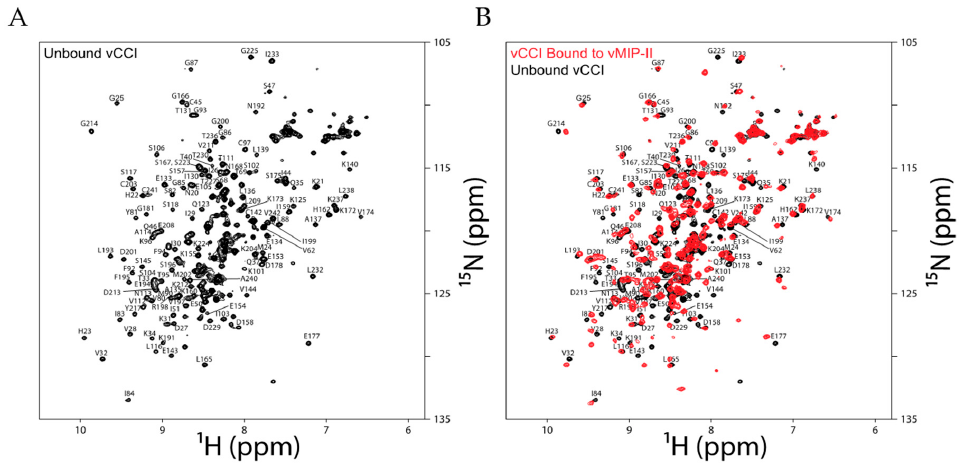
Figure 1. ( A ) 1 H- 15 N heteronuclear single quantum coherence (HSQC) spectrum of unbound 15 N-labeled vCCI in 100 mM NaCl, 20 mM NaOP (sodium phosphate) pH 7.0, measured at 37 °C; ( B ) Overlay of the 1 H- 15 N HSQC spectra of free 15 N-labeled viral CC chemokine inhibitor (vCCI) (black) and 15 N vCCI: 14 N vMIP-II (red) with a ratio of 1:3, measured under the same conditions as in ( A ). The concentration of vCCI was 50–60 µ